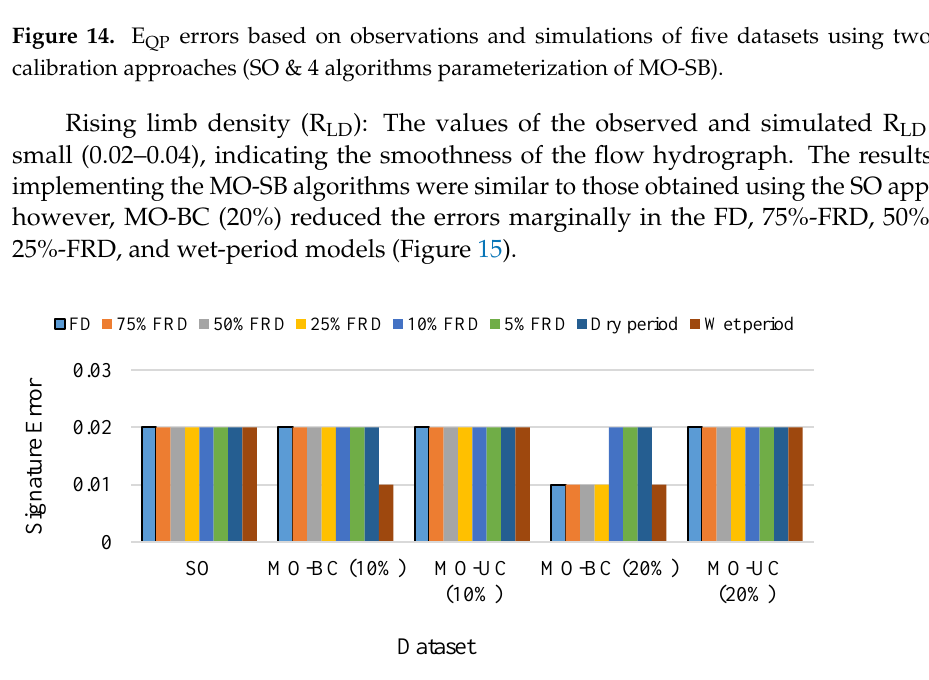
Figure 15. R LD errors based on observations and simulations of five datasets using two main calibration approaches (SO & 4 algorithms parameterization of MO-SB).